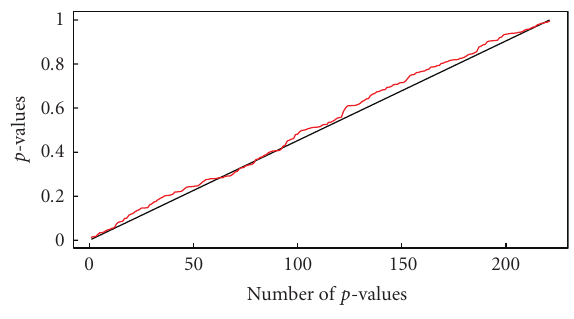
Figure 10: Results from DIEHARD.